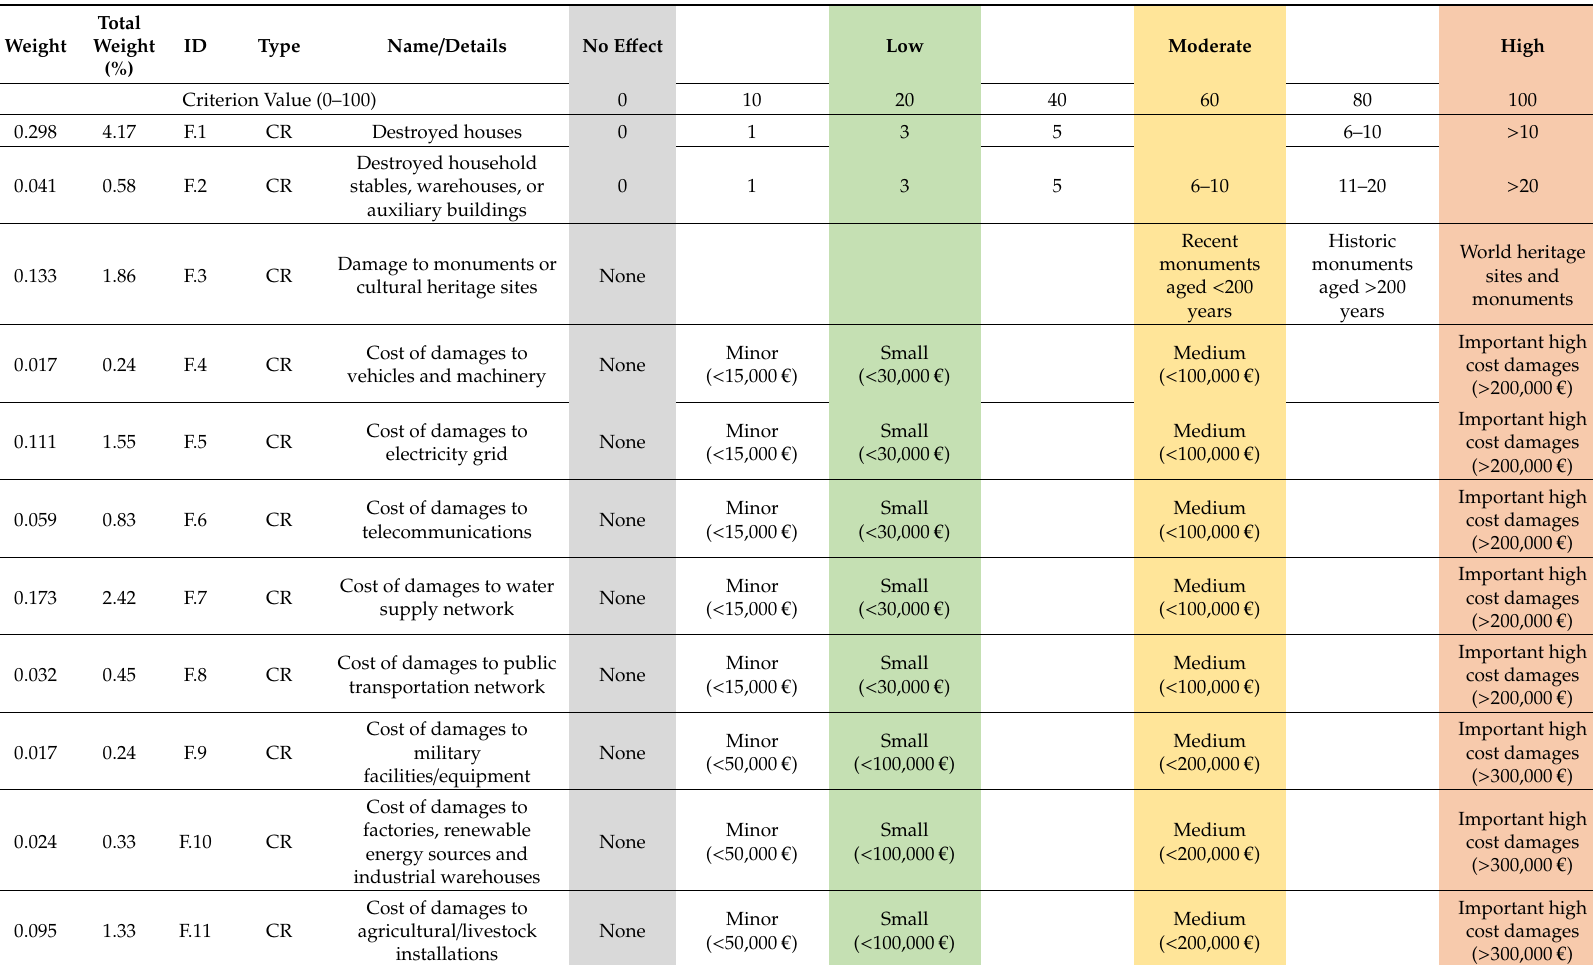
Table A6. Criteria, choices, and weights for the destruction and damages on infrastructure fire e ff ects category. CR: criterion. Light gray: Choices with no e ff ect; Dark gray: N / a, denotes a non-applicable or not available selection; Green: Choices with low e ff ect; Yellow: Choices with moderate e ff ect; Red: Choices with high e ff